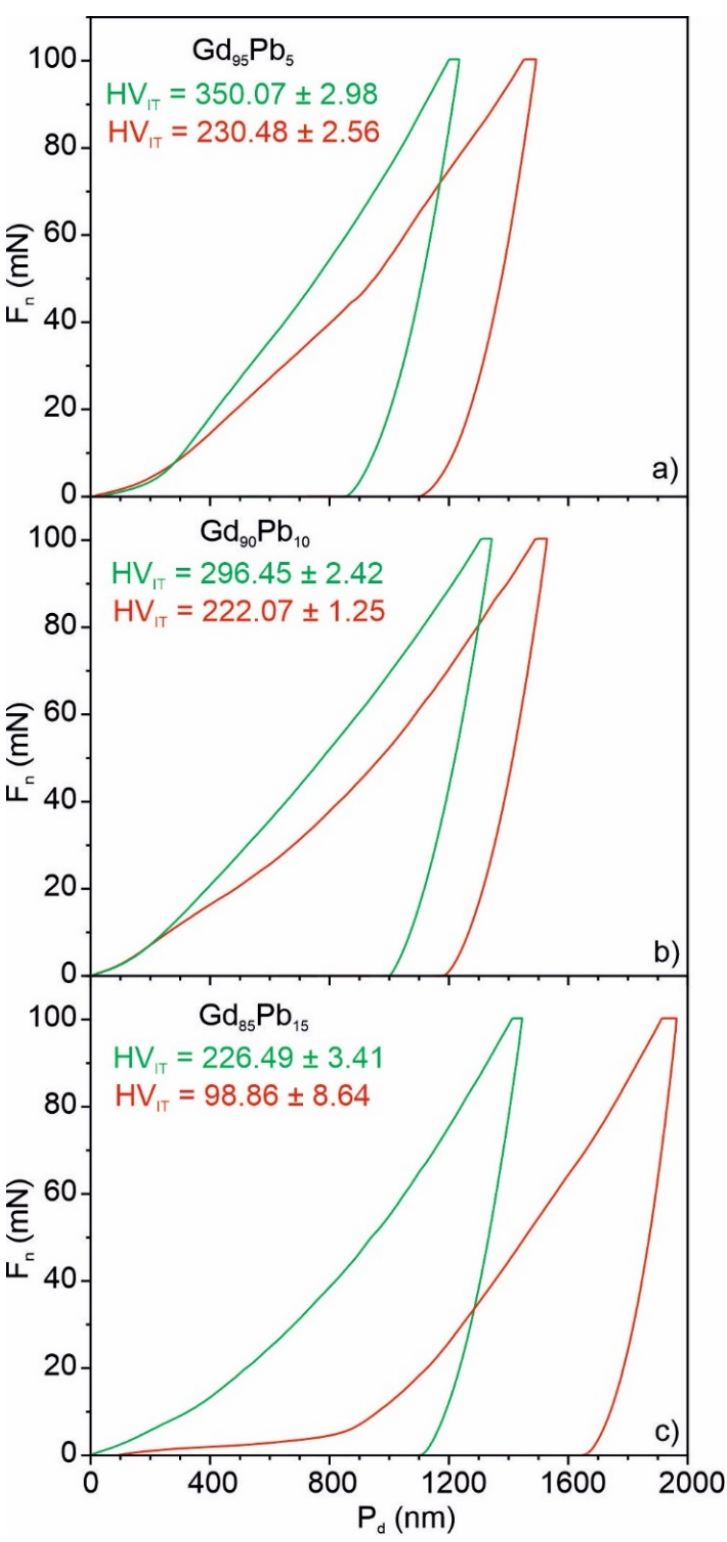
Figure 11. The example of load-displacement curves F n —P d recorded for Gd-rich and Gd-poor phases present in Gd 95 Pb 5 ( a ), Gd 90 Pb 10 ( b ) and Gd 85 Pb 15 ( c ) alloys reflecting the values exemplified in Table 5.